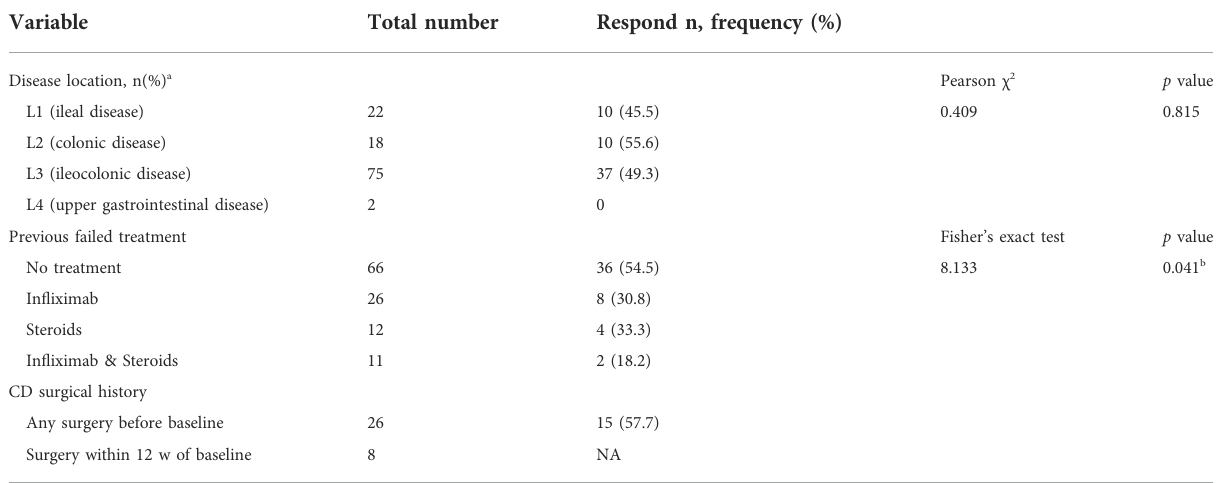
TABLE 3 Percentage of patients response to adalimumab at week